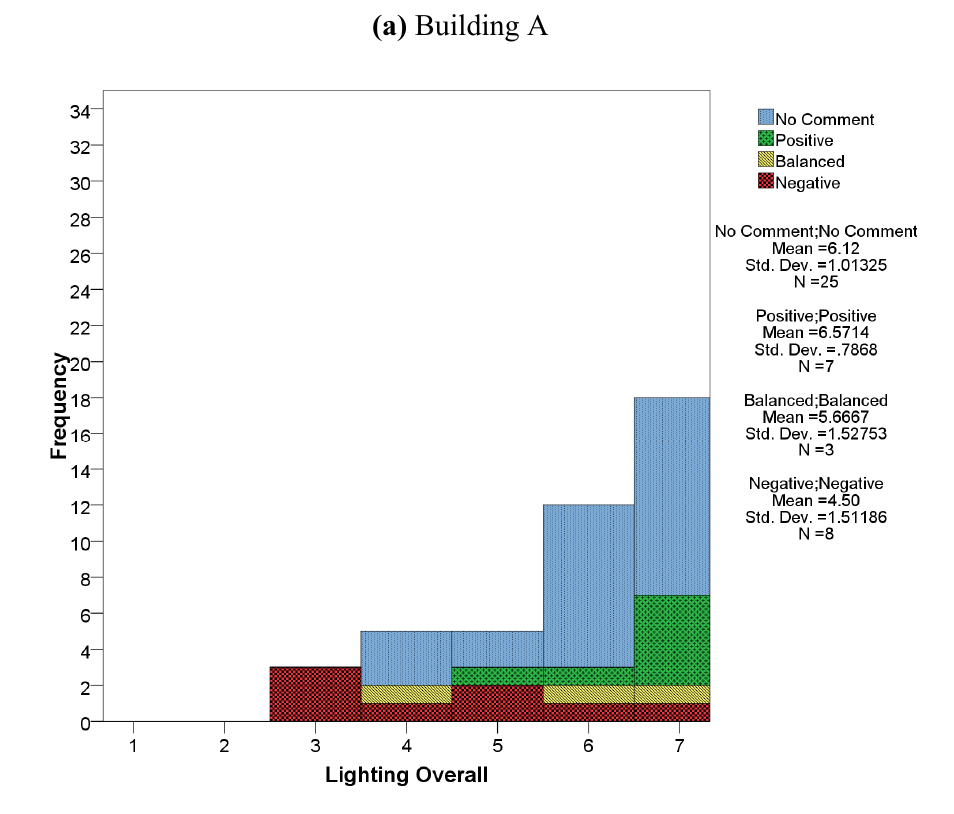
Figure 3. Histograms indicating scores and nature of the corresponding comments for Lighting